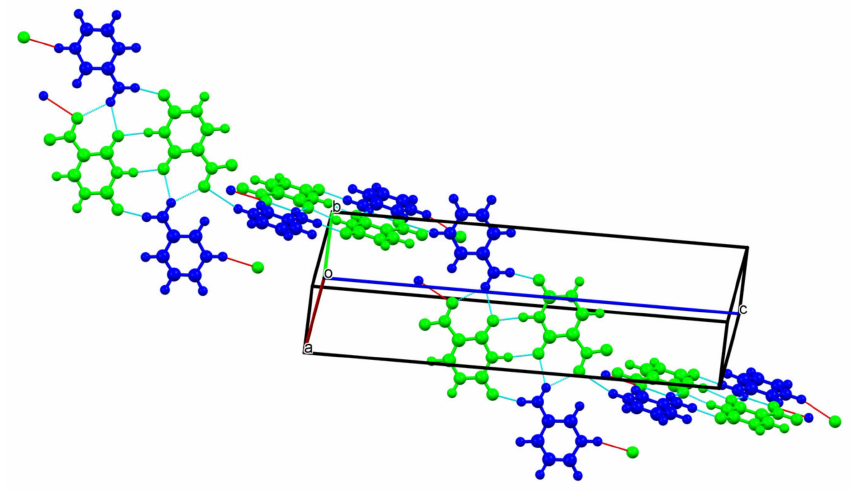
Figure 16. Crystal packing in (XV) , showing dimers with the M2